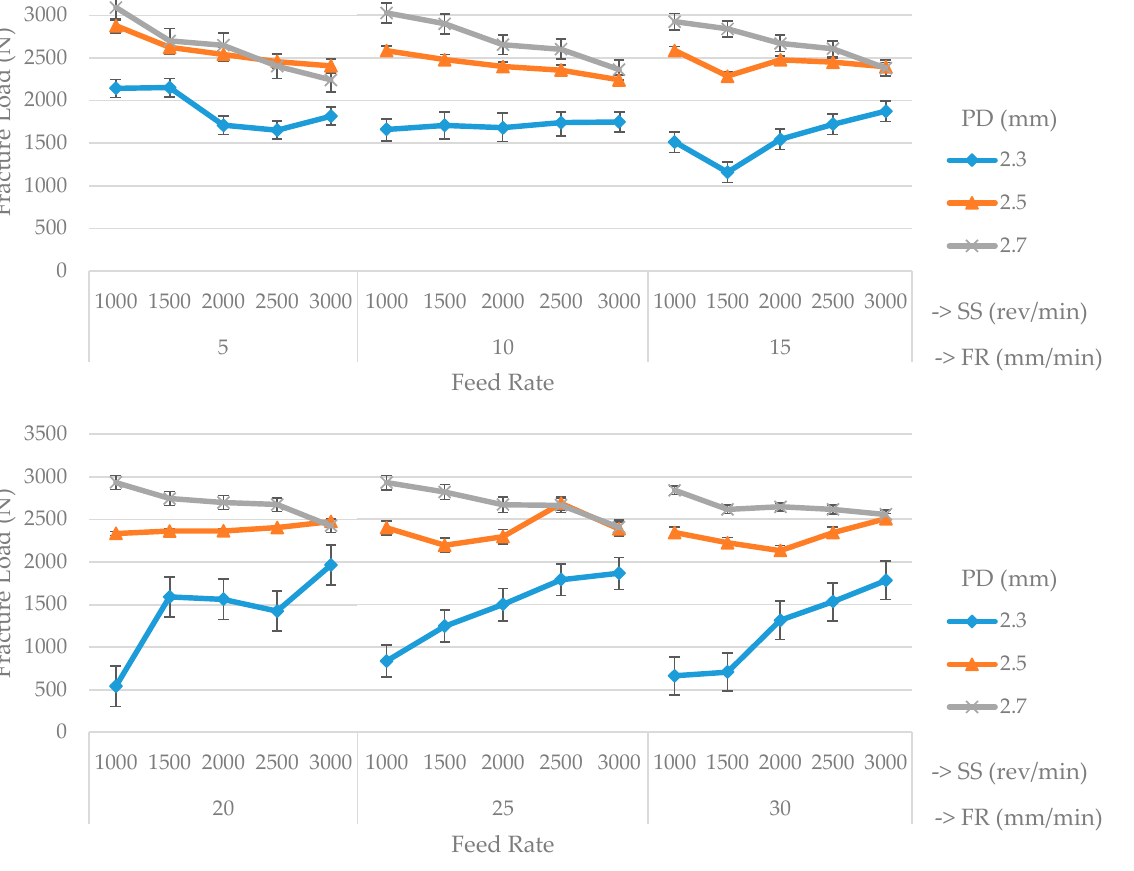
Figure 6. Welding parameter effect on tensile strength of the welded joint. The error bars show the maximum and the minimum value of the measurements.